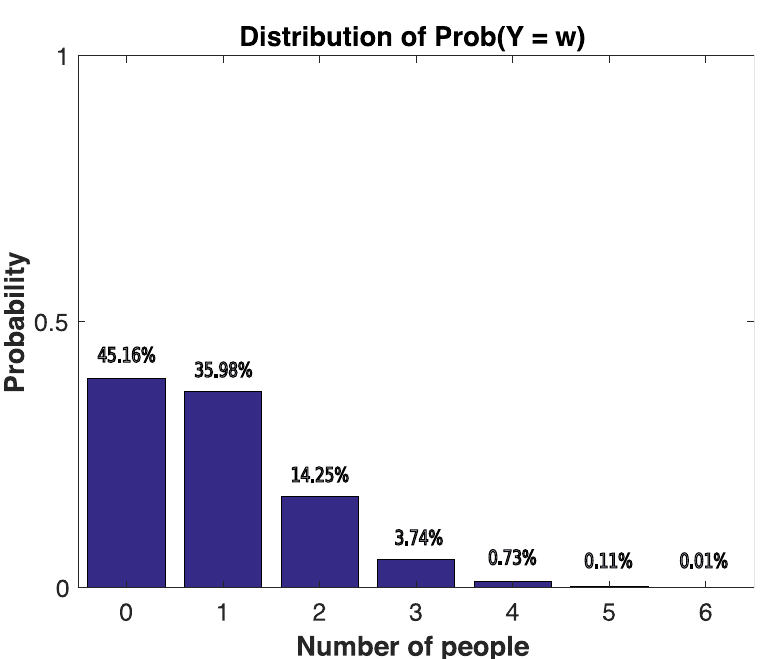
Fig 2. Sample distribution of Y in a Northern Alaskan community. Here on the x-axis is the number of subjects that put a certain pair ( v 0 , v 1 ) among all pairs of distinct subjects in the same cluster and y-axis is the corresponding probability under the assumption of the null model N